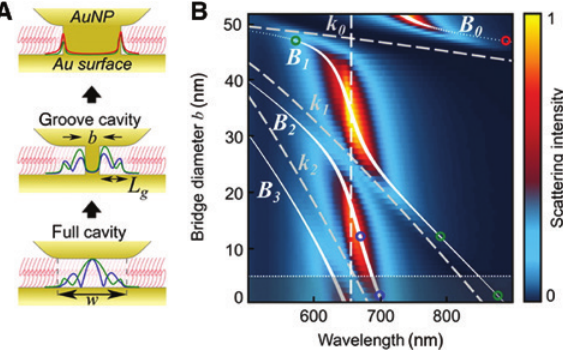
Figure 3: (A) Schematic of an NPoM with central conductive bridge linking NP and surface and (B) its corresponding finite-difference time domain simulation modes (normalized color map; yellow: high intensity, blue: low intensity).